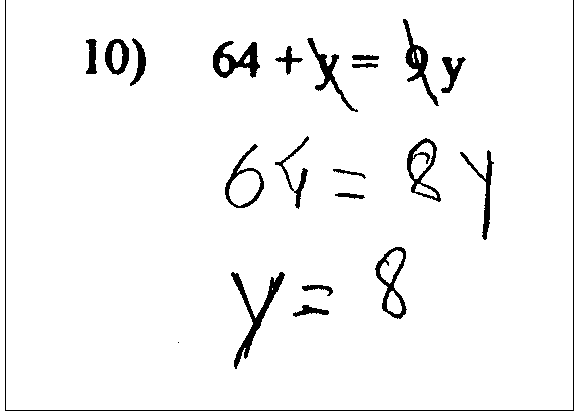
Figura 7 . Protocolo de um sujeito na resolução de uma equa- ção com uma incógnita Ou este, relativo a um problema mais complexo com duas incógnitas: